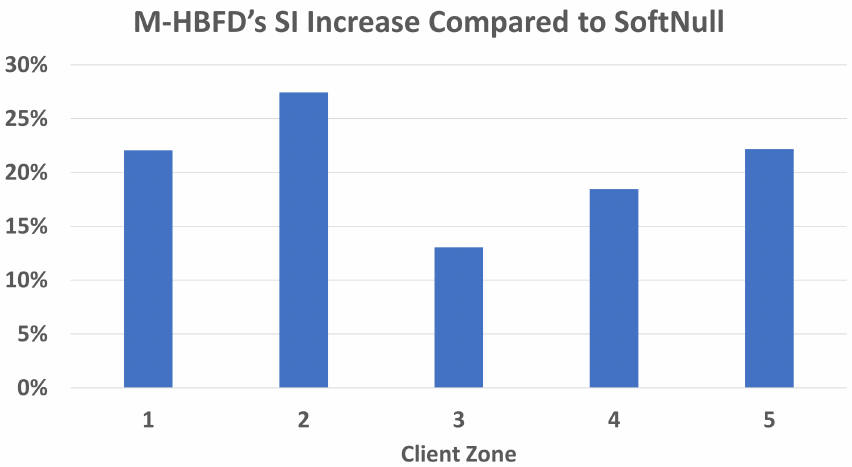
Figure 6. Effect of client zone on M-HBFD’s SI compared to SoftNull. The total SI created at the BS by M-HBFD is 15–25% higher than the SI generated by